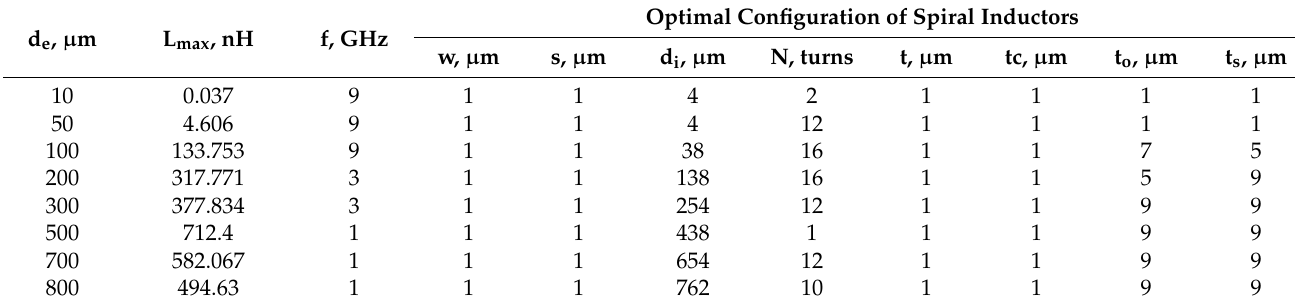
Table 3. The optimal configuration for maximal inductance in 1–10 GHz frequency domain.